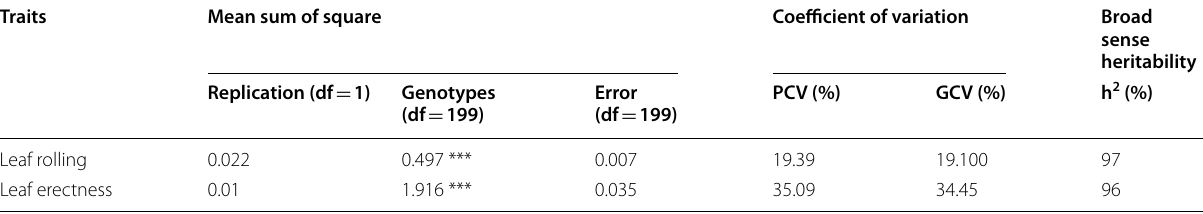
PCV phenotypic coefficient of variation, GCV genotypic coefficient of variation *** indicates significant difference at P <